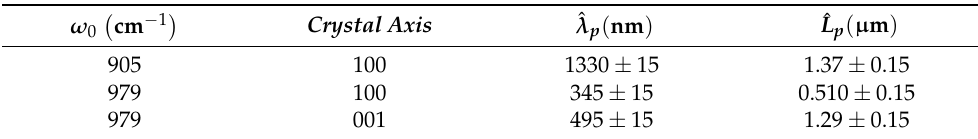
Table 2. Wavelengths (ˆ λ p ) and propagation lengths (ˆ L p ) obtained from the simulated profiles shown in Figure 3.